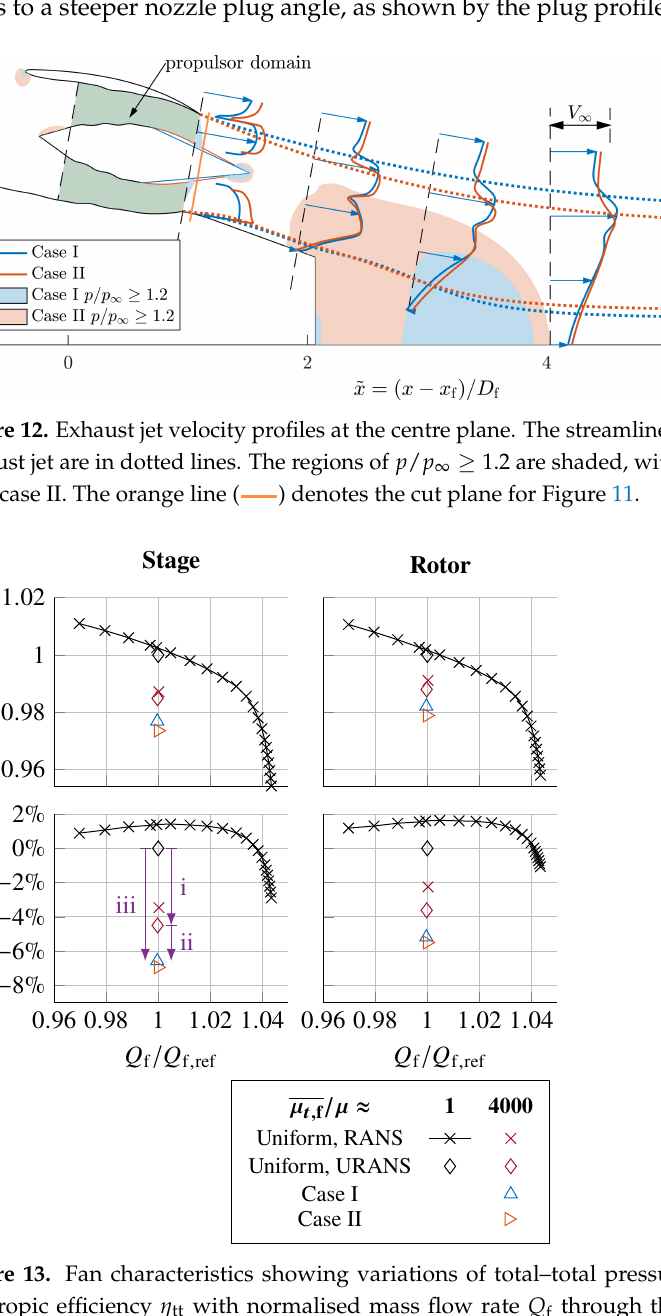
Figure 13. Fan characteristics showing variations of total–total pressure ratio r p and total–total isentropic efficiency η tt with normalised mass flow rate Q f through the propulsor at the design normalised fan rotational speed N Ω